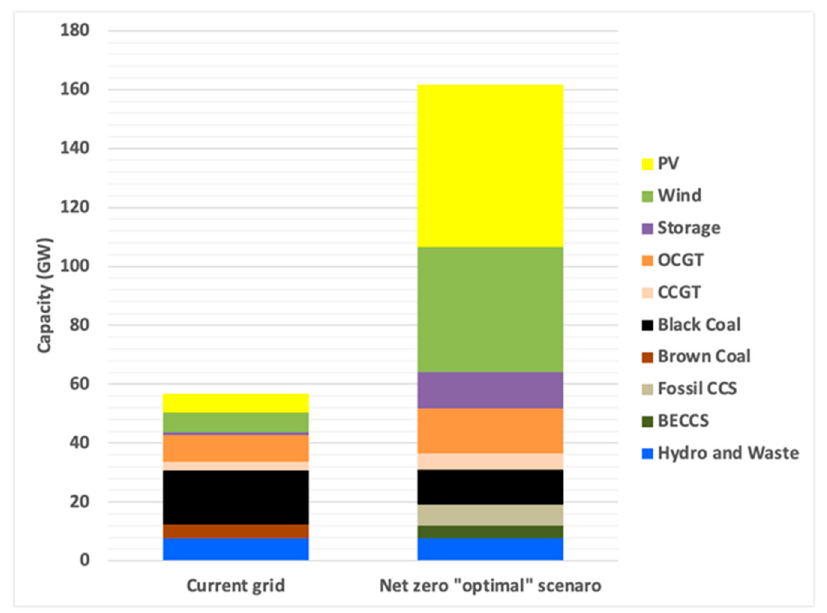
Figure 2. Current grid and net zero “no constraints” scenario installed capacity (GW) by technology, produced using the MEGS model.